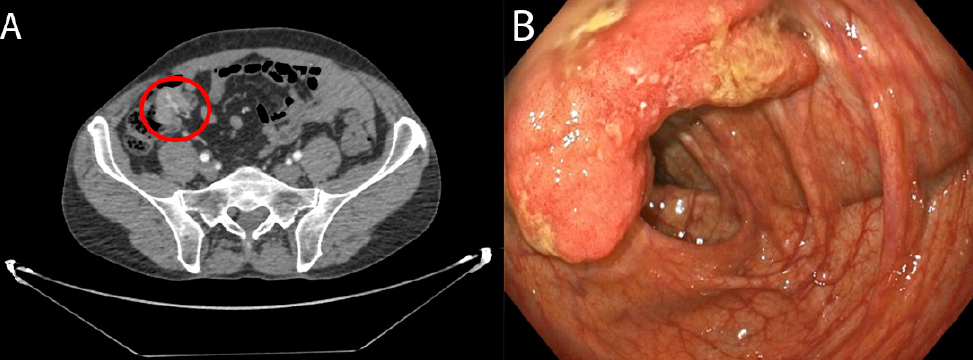
Figure 1. ( A ) Concentric wall thickening of the ileocecal valve compatible with a neoplasia. Approx- imate measures: 2.8 × 3 × 2.8 cm (T × AP × L). No spiculations on the paracecal fat or regional adenopathy are observed. ( B ) Endoscopic view of tumour. Flat and over-raised lesion with central depression of at least 20 mm in the colonic wall, suggestive of adenocarcinoma.